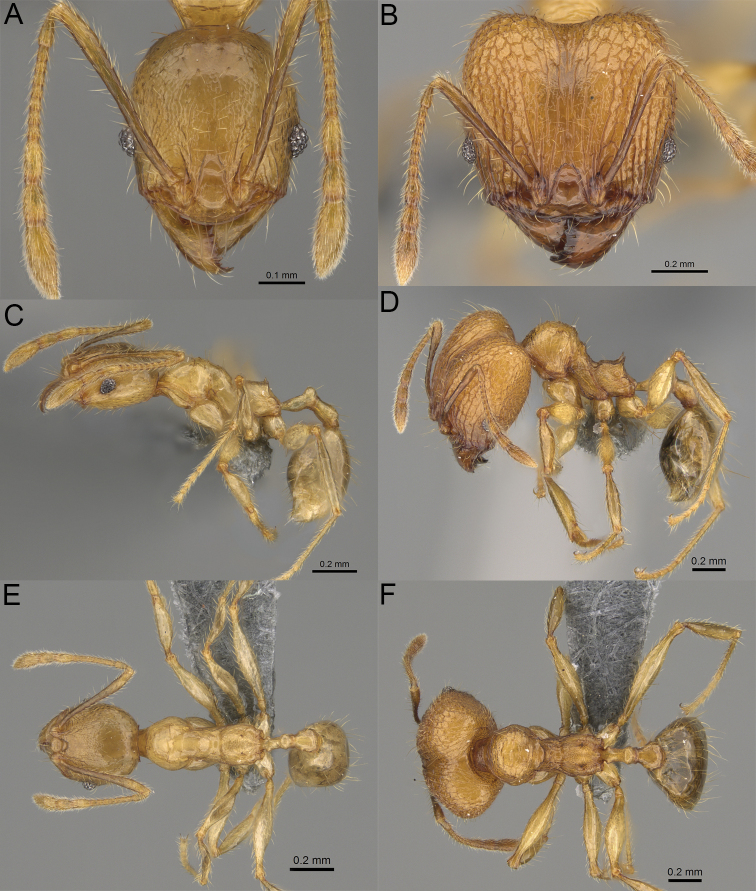
Pheidole
mamiratra sp. nov., full-face view (A), profile (C), and dorsal view (E) of paratype minor worker (CASENT0923291) and full-face view (B), profile (D), and dorsal view (F) of holotype major worker (CASENT0303725).